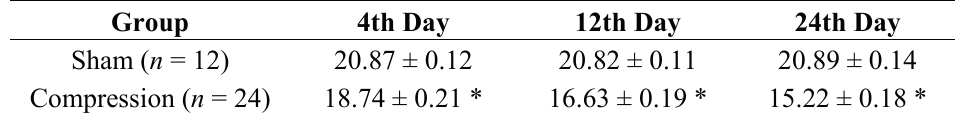
Table 1. Average BBB score of the two groups in checking compression time (* p < 0.05).